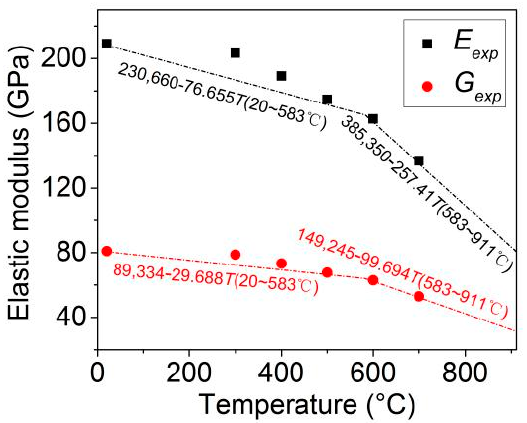
Figure 3. The experimentally measured Young’s elastic modulus E exp and shear elastic modulus G exp at different temperatures (the dotted line is the calculated value).